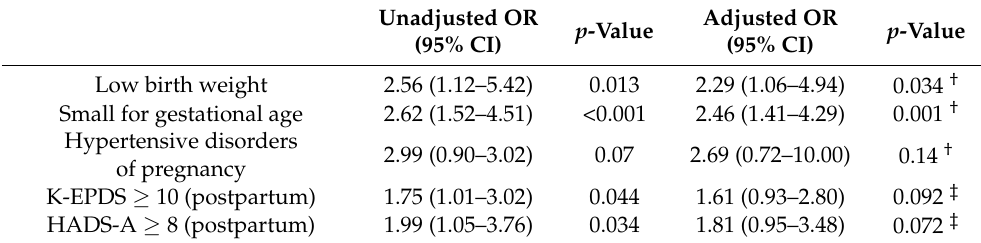
Table 5. Risks of adverse outcomes due to anemia during the first trimester.